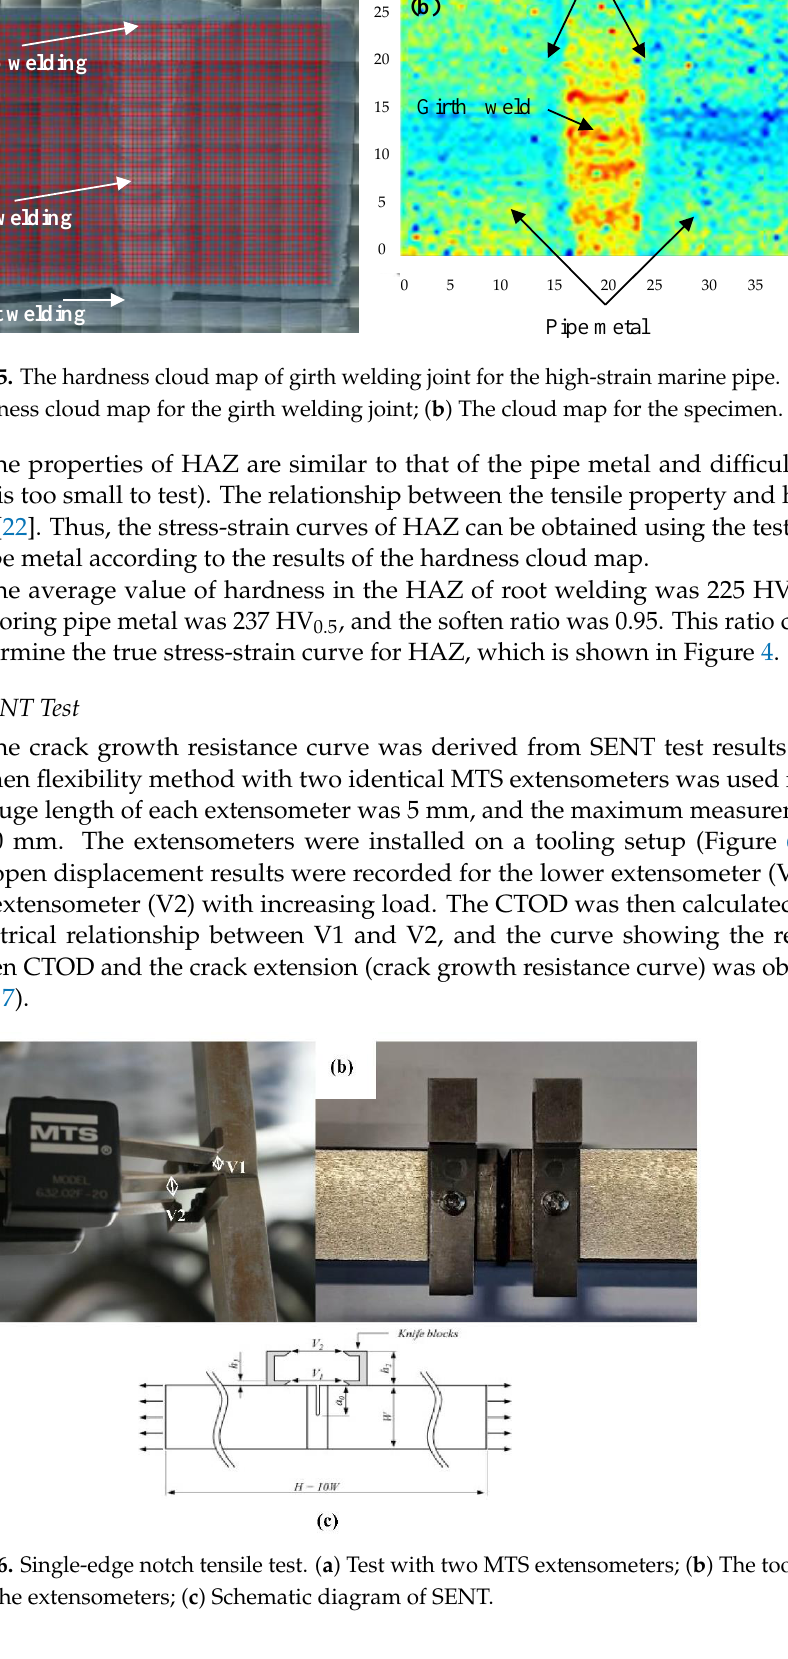
b0 . 422190 . 01407 Figure 7. Crack growth resistance of the specimen (notch depth is 8.4 mm) by SENT. The fitting function in Figure 7 is 𝑦 = 𝑎𝑥 𝑏 (3) where a = 1.52 and b = 0.42. 4. FEA Process The FE models of the whole pipe with four crack sizes were constructed using Abaqus 6.11(Dassault Systèmes, France). The four notch sizes (depth × length) were 4 mm × 50 mm, 7 mm × 87.5 mm, 10 mm × 125 mm, 13 mm × 162.5 mm and 16 mm × 200 mm, respectively. The length of the pipe was 12,000 mm, the thickness was 31.8 mm, the orig- inal CTOD was 0.2 mm and the OD was 559 mm, which was the same size as the pipe in the full-size bending test. The welding joint was divided into pipe metal, HAZ and weld metal. The color of the meshes were white, green, blue and red, as shown in Figure 8b. The material proper- ties (true stress-strain curves) of the pipe metal, HAZ and the weld metal were assessed. The crack was set up between the HAZ and weld metal (along the fusion line), as shown in Figure 8c.